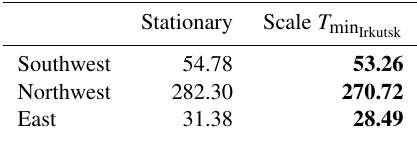
Table 9. BIC values of GPD models using Irkutsk data for three